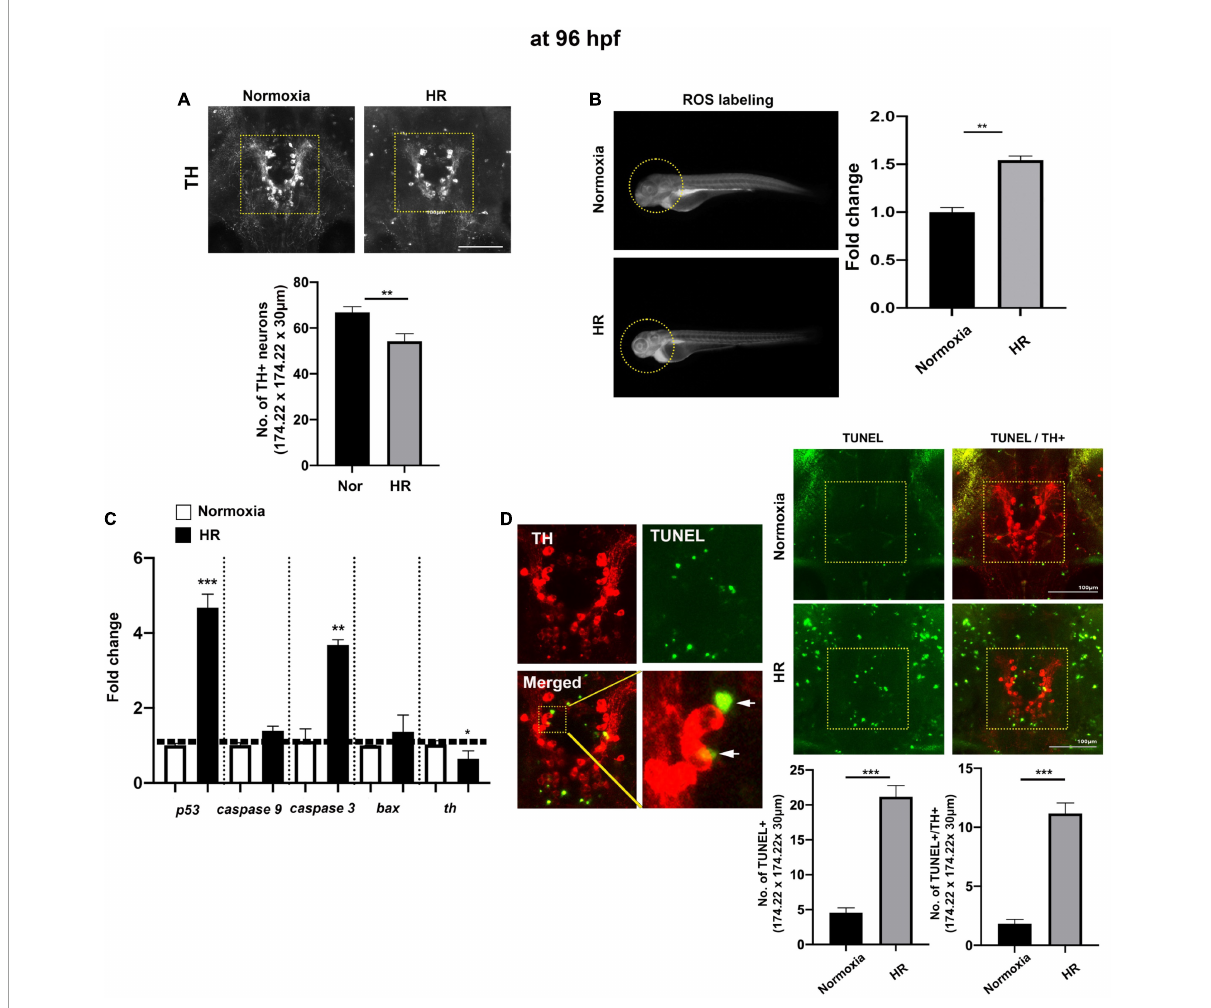
FIGURE2 The indirect “catch-up” response to hypoxia (i.e., HR) at 96 hpf following hypoxia. (A) The Z-stack confocal images (ventral views, rostral to the top) were used to determine the maximum intensity projections and the number of TH + neurons in the diencephalic area (170.22 µ m × 170.22 µ m × 30 µ m) in normoxic ( n = 11) and HR zebrafish ( n = 12) analyzed with Student’s t -test and shown as Means ± SEM, (B) the ROS production/accumulation in zebrafish head analyzed with Student’s t -test and presented as fold changes in HR zebrafish ( n = 5) compared to controls ( n = 5), (C) the expression of proapoptotic genes ( p53, caspase9, caspase3 , and bax ) and tyrosine hydroxylase ( th ) in normoxic and HR zebrafish ( n = 6/group, triplicated) corresponding to the expression of reference gene (hatn10) analyzed with Student’s t -test and presented by percent changes compared to normoxic controls ( n = 6/group, triplicated), (D) the magnified TH + , TUNEL + , and merged TH + /TUNEL + images and arrows indicate TUNEL + and TH + neurons. The TUNEL labeling in green and anti-TH in